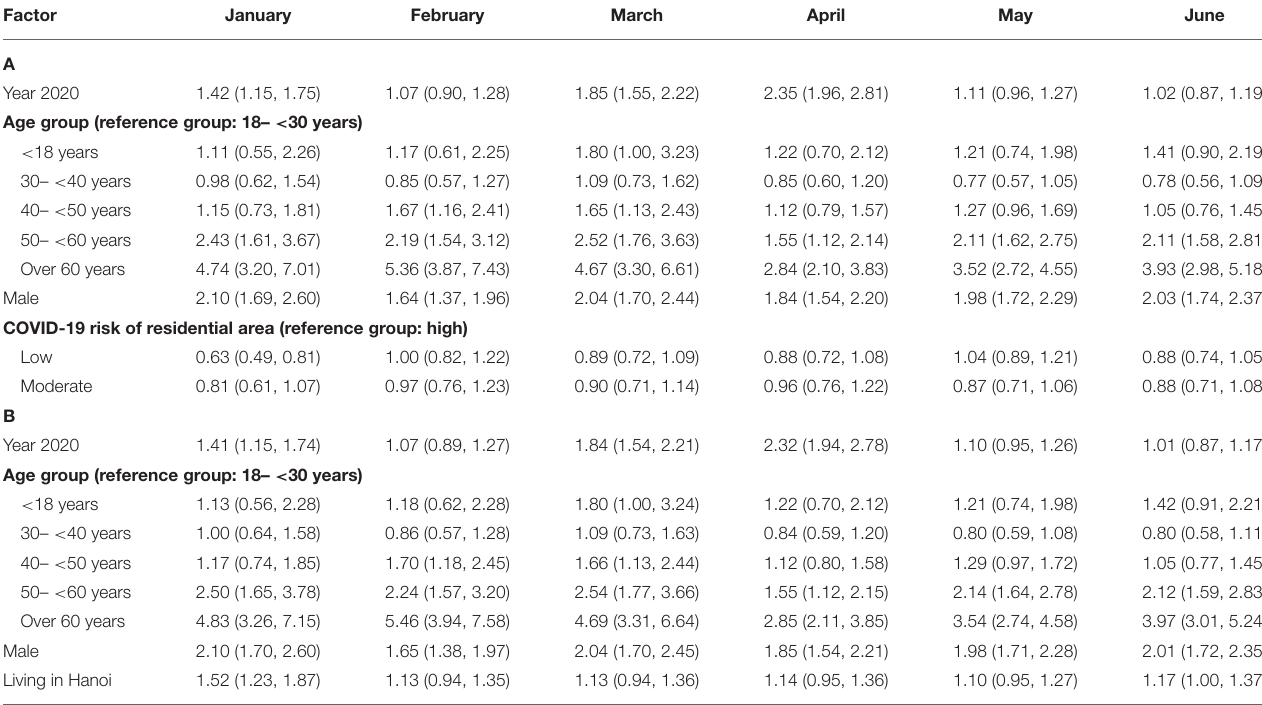
TABLE 2 | The log-binomial models for the proportion of GI emergency endoscopy.